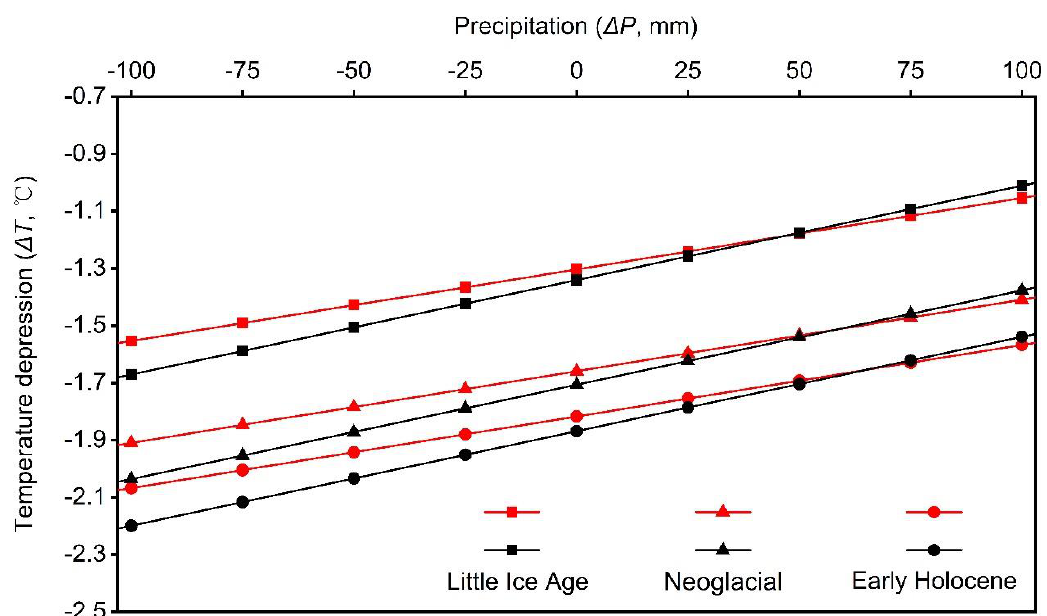
Figure 6. Plots of the temperature and precipitation combinations that yield Little Ice Age, Neoglacial and Early Holocene glacial extents in model simulations. Note that the red lines were plotted by using ( ∂ P / ∂ T ) ELA−1 value of 2.5 × 10 −3 °C/mm, the black lines by 3.3 × 10 −3 °C/mm. See the text for details. The uncertainties of calculated ∆ T and ∆ P for the three Holocene glacial stages are determined by the errors in ELA, temperature lapse rate and precipitation gradient (Equation (5)). According to Pellitero et al. (2015) [36], the uncertainty in the estimated ELA mainly derives from the delineation of the paleo-glacier boundaries. Pellitero et al. (2015) [36] also suggested that the calculation error (i.e., the minimum error) is equal to the chosen contour interval. In calculation of the ELA, we used the contour interval of 50 m, so the uncertainty of the reconstructed ELA is about ± 25 m. Using Equation (5), we tested the sensitivity of the inferred paleoclimate to the uncertainties related to the ELA, temperature ◦ lapse rate and the precipitation gradient. The ± 25 m error in the ELA results in an uncertainty of ± 0.2 C ◦ for the inferred temperature. Varying the temperature lapse rate of ± 0.10 C / 100 m makes the inferred ◦ temperature change by ± 0.23 C; similarly, varying the precipitation gradient by ± 10 mm / year / 100 m, ◦ leads to variations in the inferred temperature of ± 0.06 C. We therefore suggest that the uncertainty in the inferred summer temperature change ( ∆ T ) for each of the Holocene glacial stages is of about ± 0.53 ◦